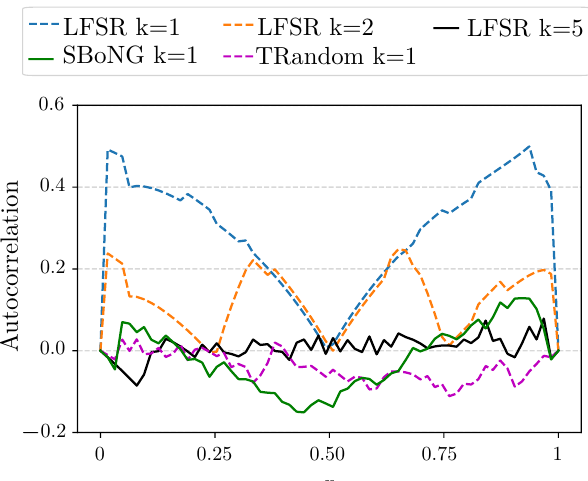
Figure 8. Autocorrelation comparison for the LFSR, TRNG (TRandom), and SBoNG methods when initial input x value has different